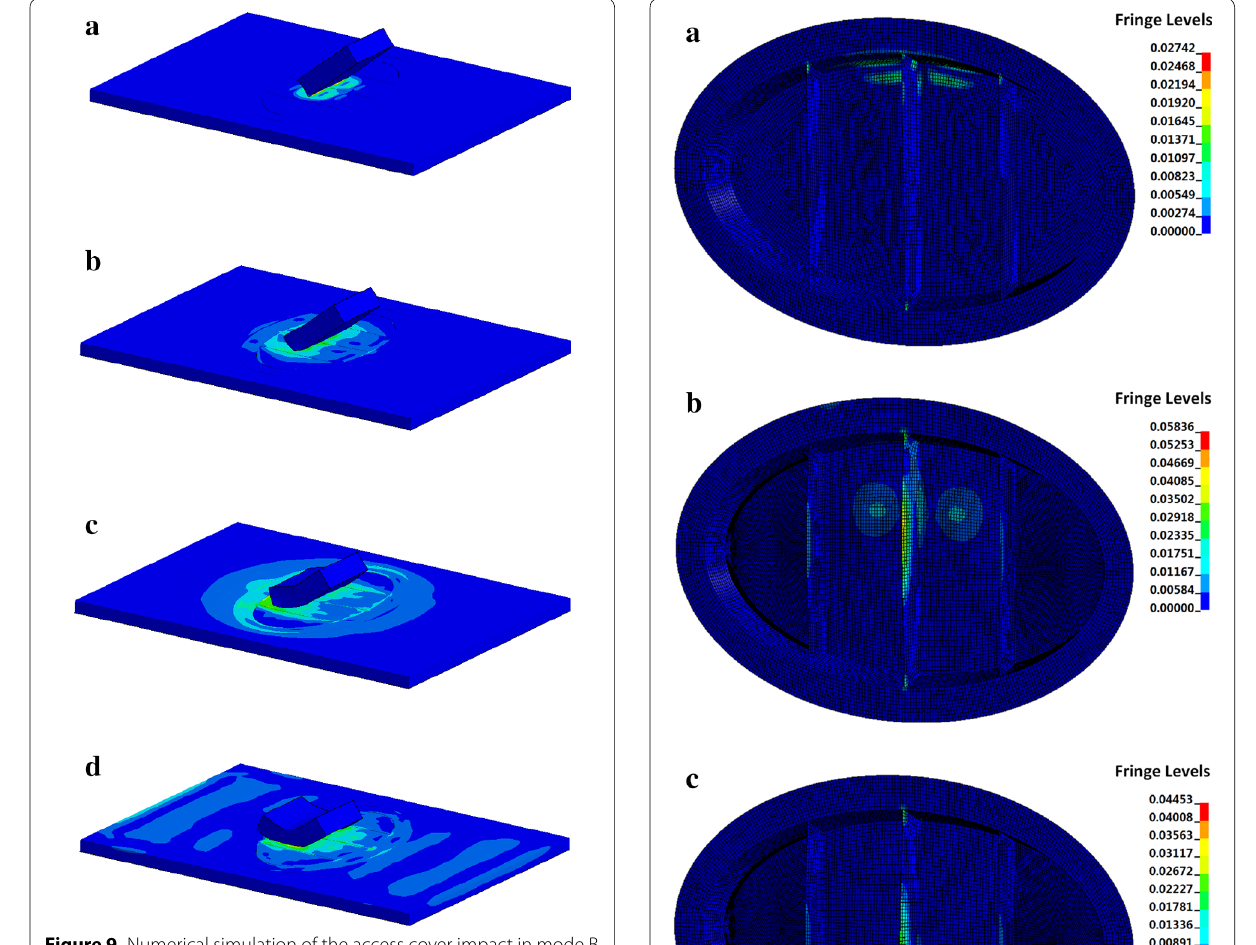
0.15 ms, ( b ) t 0.5 ms, ( c ) t 1 = = =